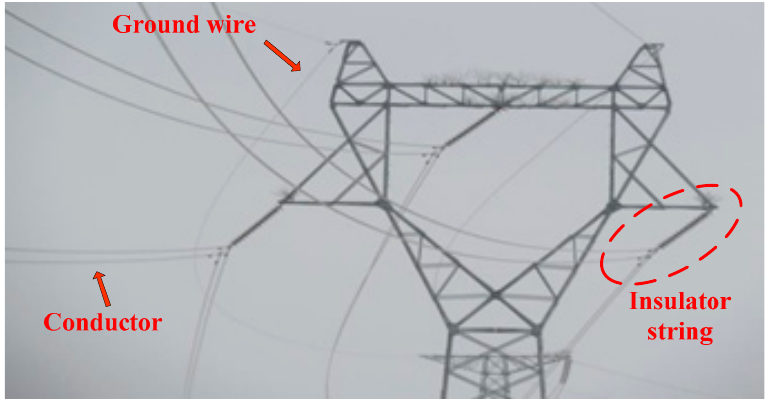
Figure 1. Windage yaw phenomenon of transmission line.